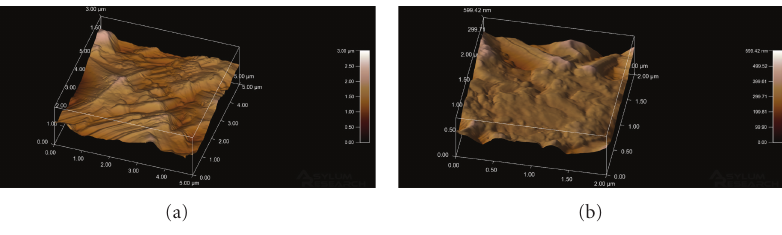
Figure 2: AFM images: (a) Porous and (b) PorousNano.